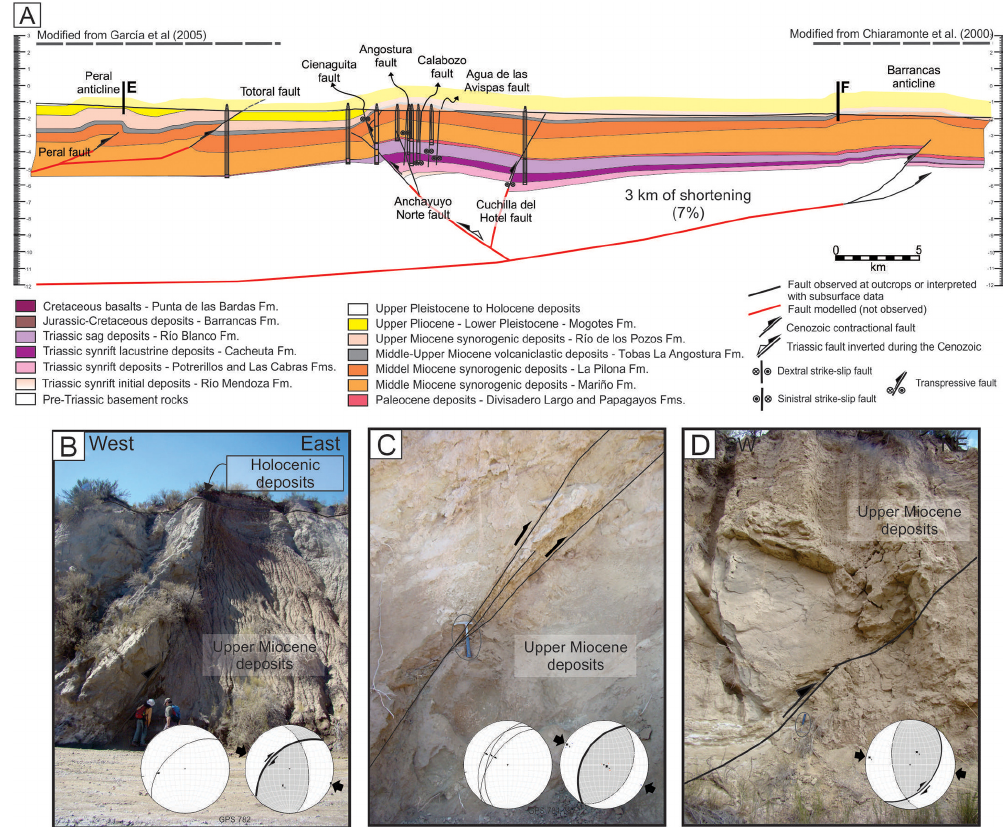
Figure 6. (a) Tupungato cross section. See location at Fig. 4. (b–d) Photographs of the main and subsidiary planes of the Cienaguita fault, with kinematic indicators of a reverse/strike-slip movement (see locations in Fig.